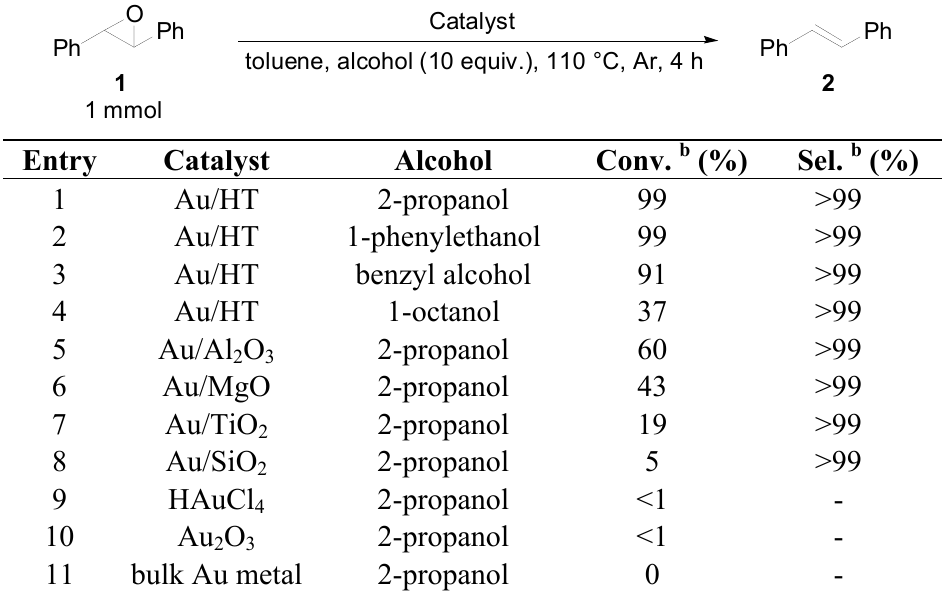
Table 1. Deoxygenation of trans -stilbene oxide a .